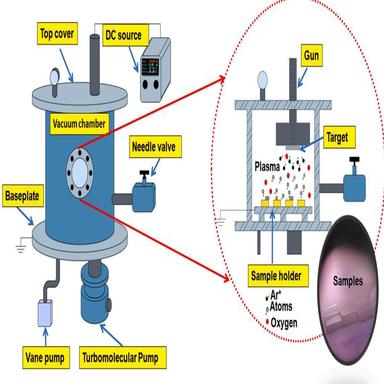
Schematic drawing of the sputtering system used in the present work. Illustration adapted from Machuno et al.